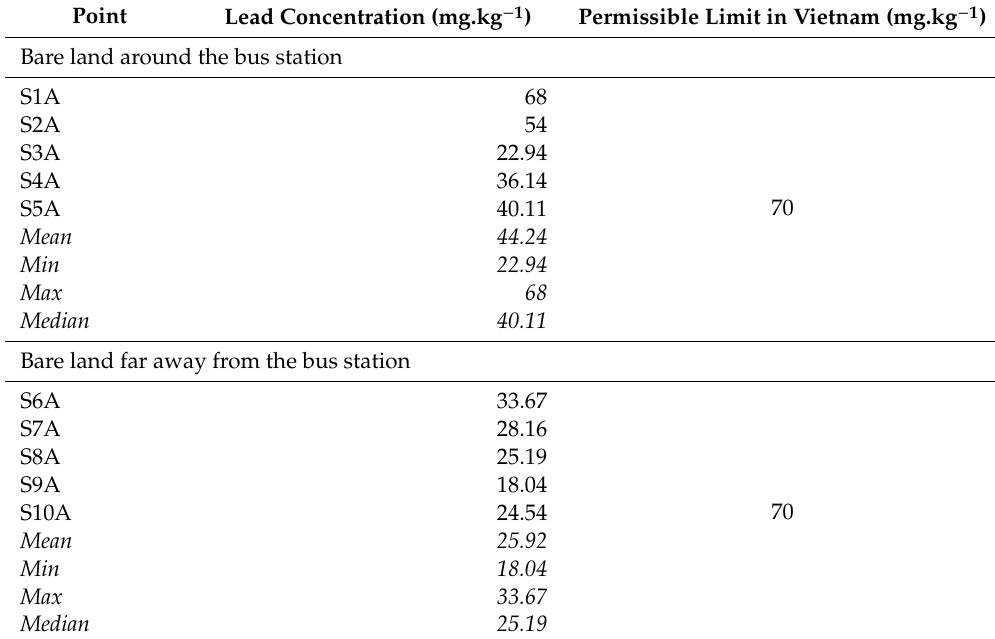
Table A1. Raw data of lead concentration measured from the soil samples.